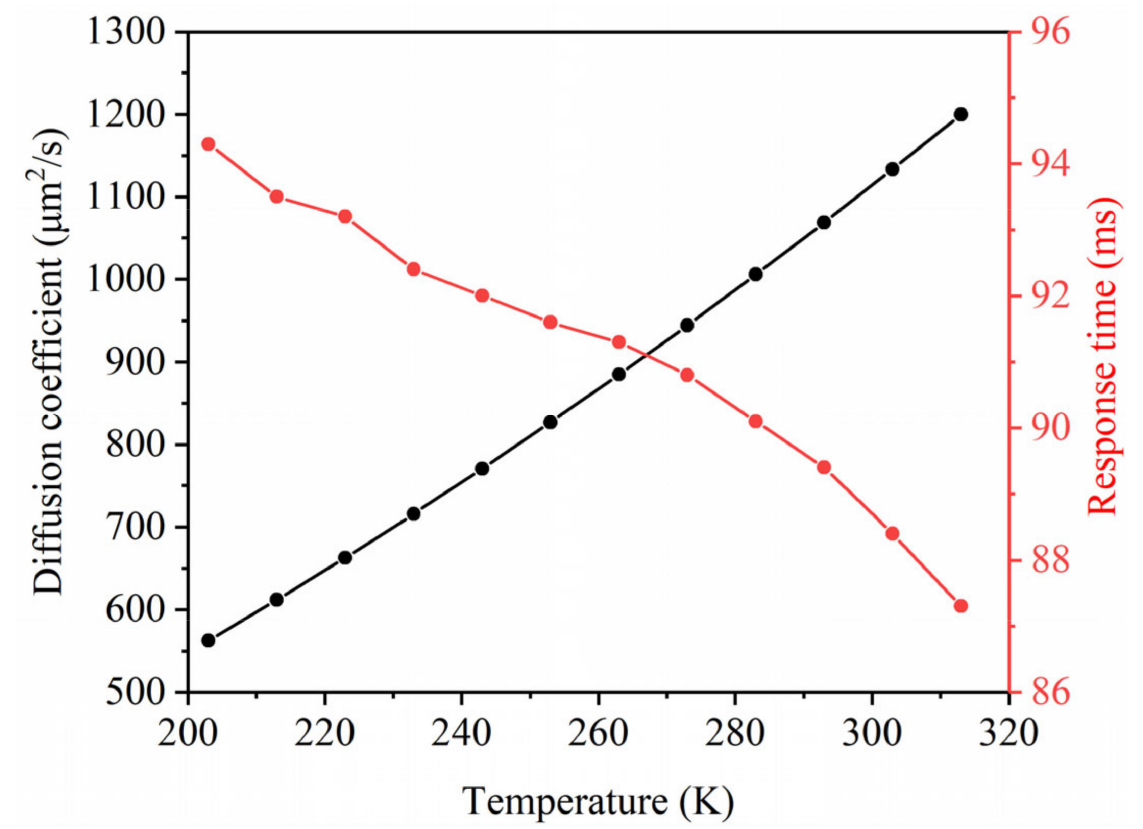
Figure 7. The diffusion coefficient of water molecules in the MXene-based sensitive layer at different temperatures (black line) and the response time of the sensitive layer with a thickness of 1 µ m (red